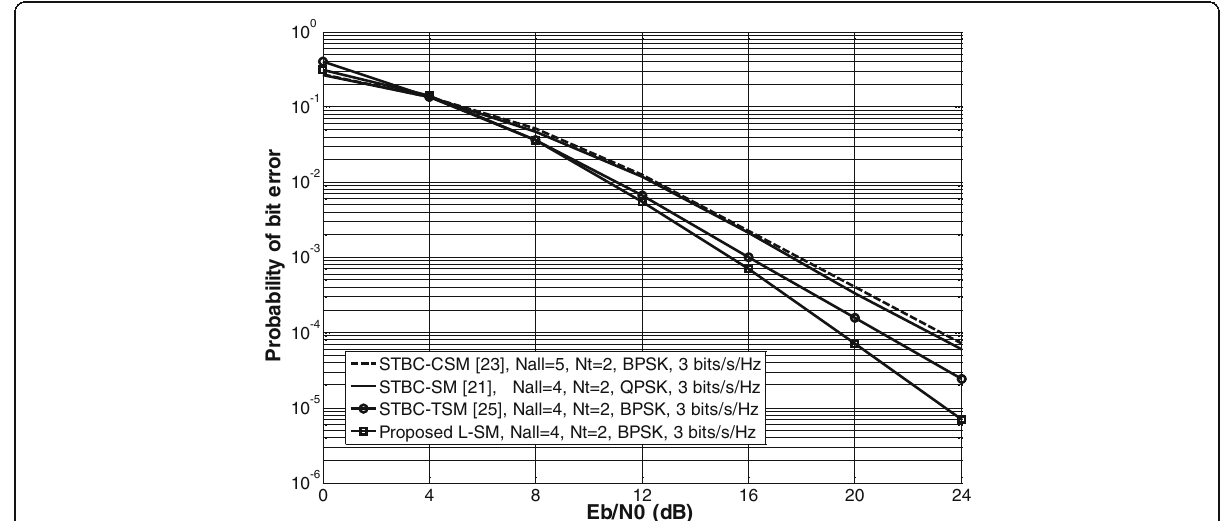
Fig. 4 Performance comparison of STBC-CSM, STBC-SM, STBC-TSM, and proposed L-SM schemes with N r = 1 for 3